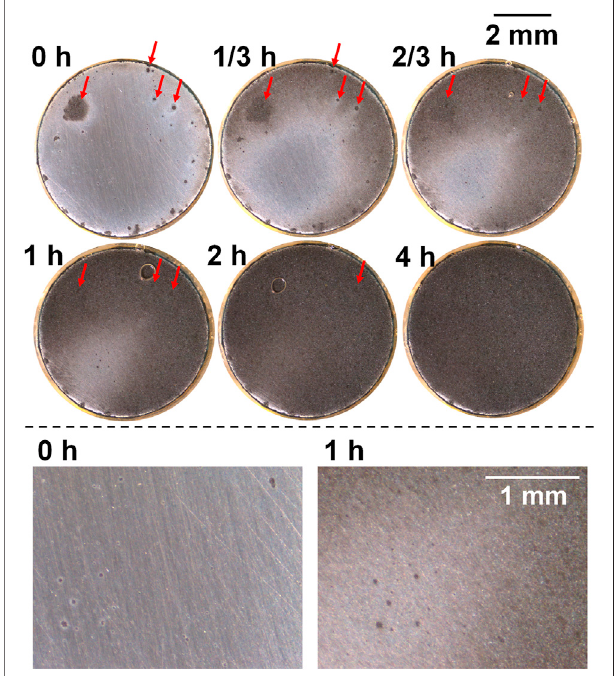
FIGURE 7 | Macrographs of the surface of the sample after heat treatmentwithcoolingrate5 ° C/spresentingcrevicecorrosiondevelopmentat 0.15 V vs. OCP in 0.1 M NaCl, taken by the self-designed device (lower part shows bottom left of